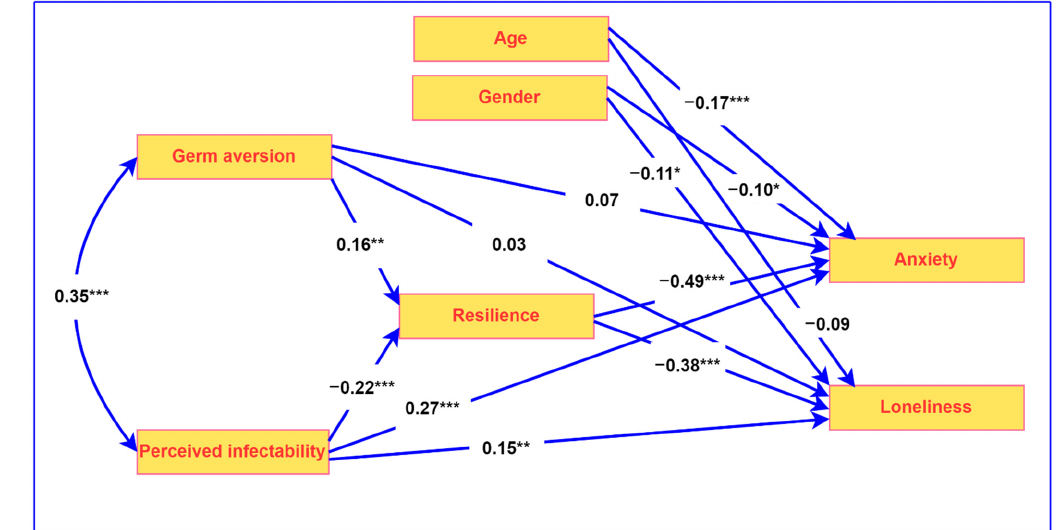
Figure 1. Path analysis model of the mediating role of resilience (*** p < 0.001, ** p < 0.01, * p < 0.05).